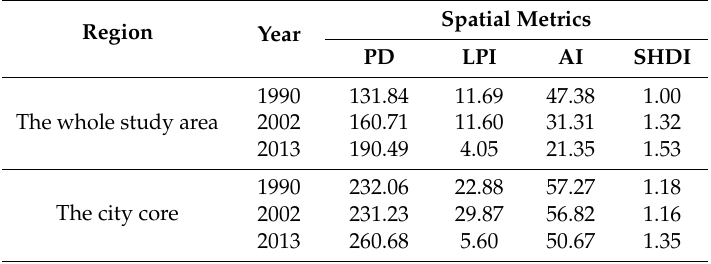
Table 3. Spatial metrics for the whole study area and the old city core at landscape